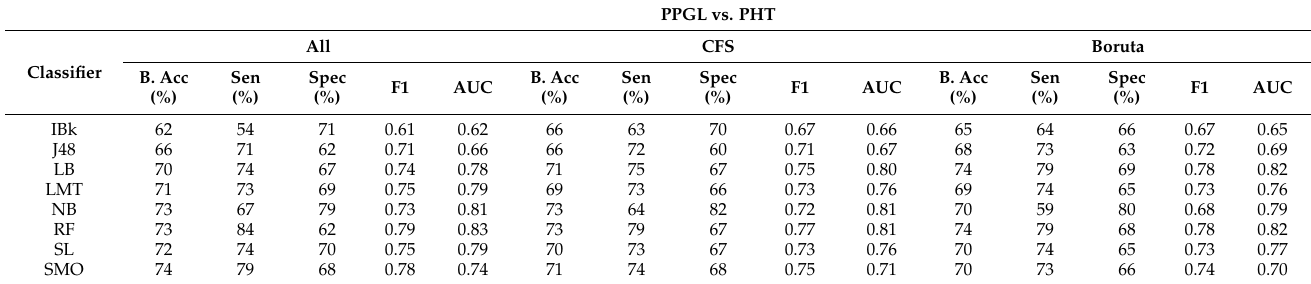
Table A6. Mean balanced accuracy, sensitivity, and specificity for PPGL vs. PHT disease comparison using various classifiers with all features, CFS, and Boruta feature selection methods.